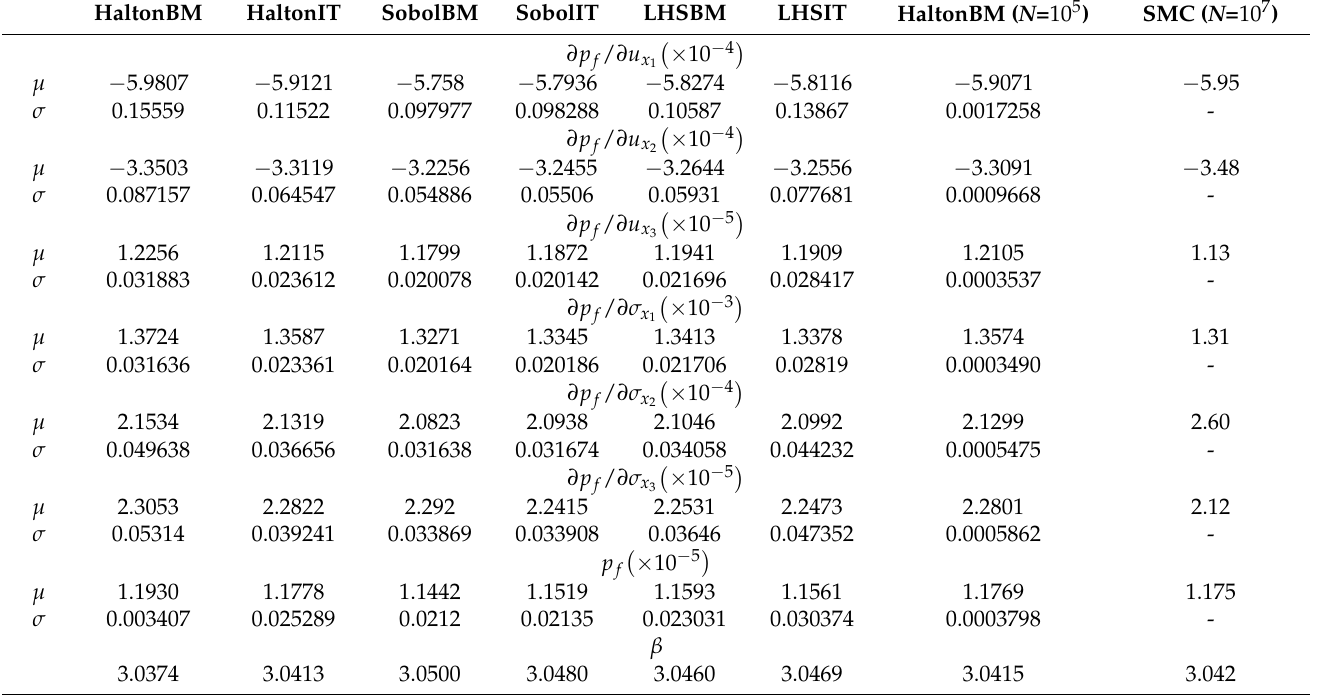
Table 2. Reliability and sensitivity results in Example 1 when N =